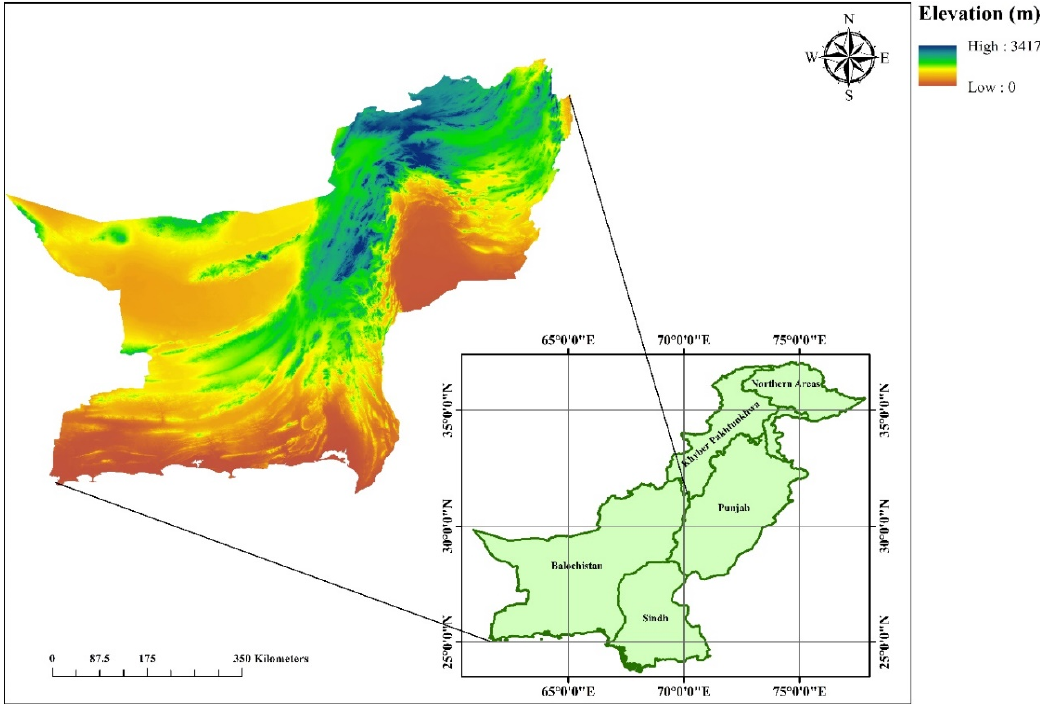
Figure 1. Elevation map of Balochistan.